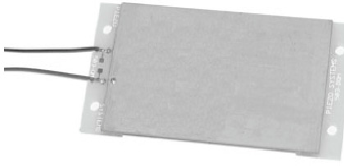
Figure 8. Prototype of the piezoelectric vibration transducers (PVT). Table 1. Piezoelectric vibration transducer parameters.